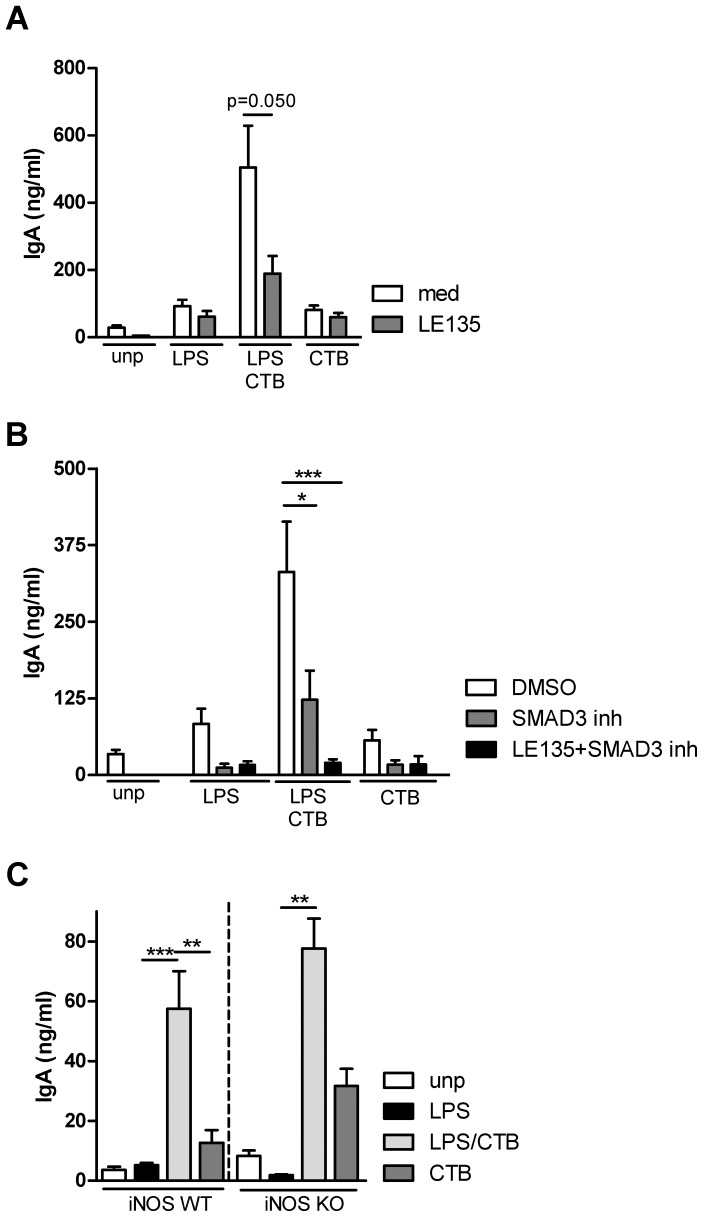
In vitro, RA and TGF-β are responsible for IgA induction by CTB-primed DCs.BM-DCs were pulsed with PBS, LPS (100 ng/ml), LPS+ CTB (10 µg/ml) or CTB alone and co-cultured as described at Figure 1. (A) During the co-culture the RA receptor was blocked by LE135 (1 µM). After 7 days, IgA levels were measured in supernatant. (B) Similar as in A, but here in the presence of SB-431542 (5 µM) (or vehicle) alone to inhibit TGFβ-specific signaling or together with LE135. After 7 days, IgA levels were measured in supernatant. (C) BM-DC and B cells were co-cultured as described, however the DC were WT or deficient for iNOS (C57/Bl6 background). Data shown are mean +/− s.e.m from at least 3 pooled experiments * P<0.05, ** P<0.01, *** P<0.001.